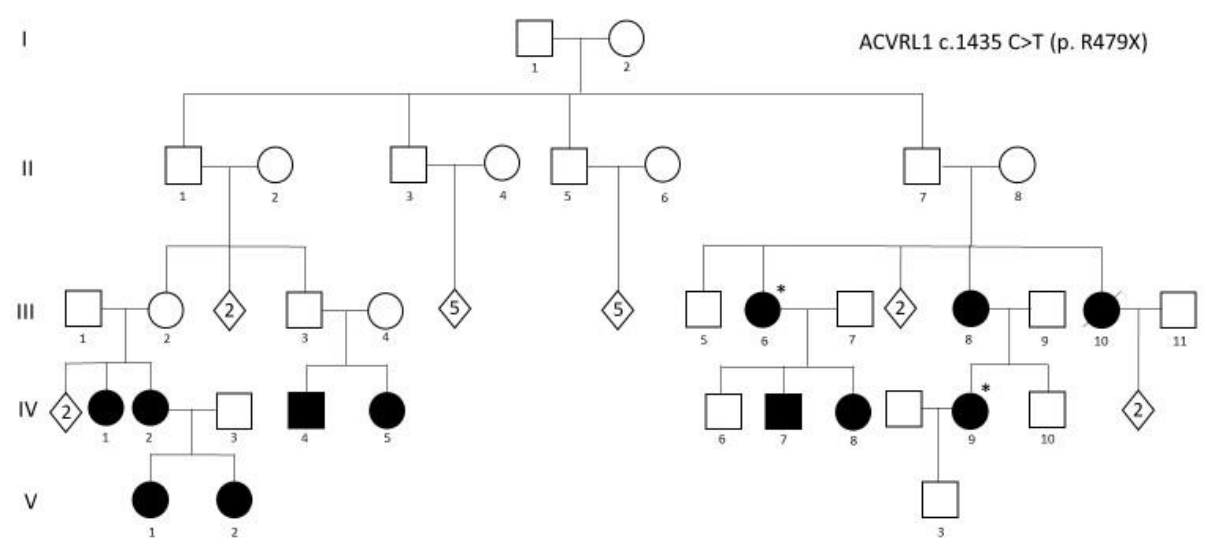
Figure 3. Index case IV,9 was diagnosed as affected with pulmonary arterial hypertension (PAH). Black symbols: carrier of ACVRL1 c.1435 C > T (p. R479X) mutation and affected by HHT. “*” indicates mutation carriers presenting both HHT and PAH.